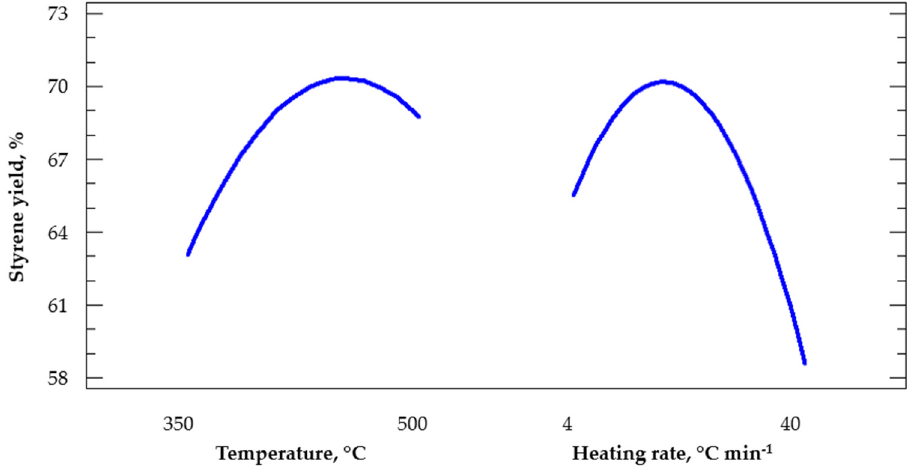
Figure 9. Main effects on styrene production.